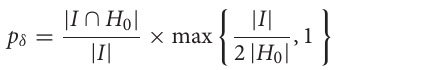
H − 0 H + 0 (cid:3) (cid:2)